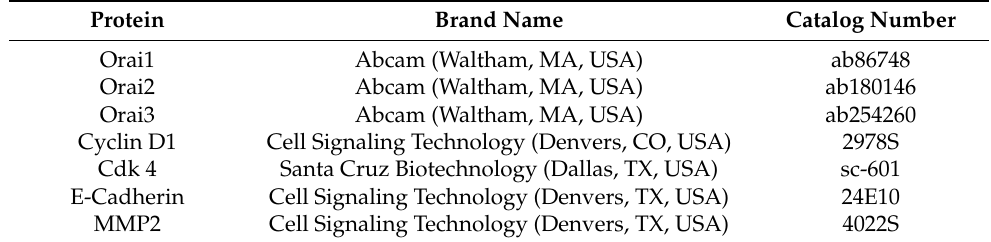
Table 1. Details of antibodies used in the study.